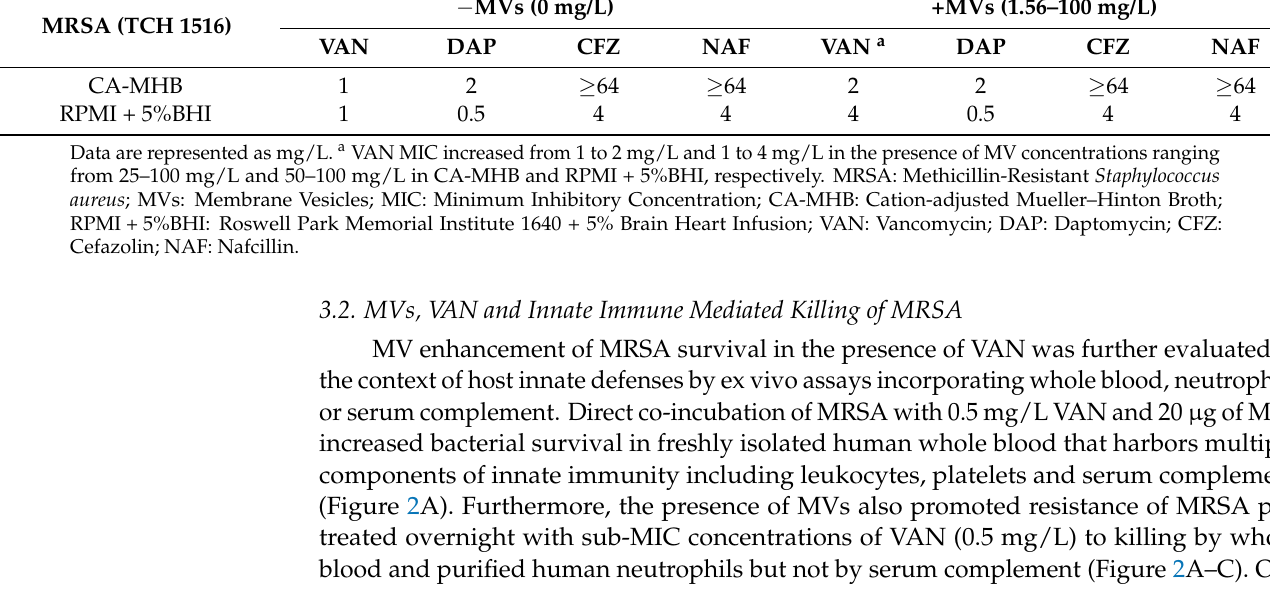
Table 1. Antimicrobial susceptibility of methicillin-resistant Staphylococcus aureus (MRSA) to cell-wall- or cell-membrane- targeting antibiotics in the absence and presence of exogenous bacterial-derived membrane vesicles (MVs) determined using minimum inhibitory concentration (MIC) and checkerboard assays.